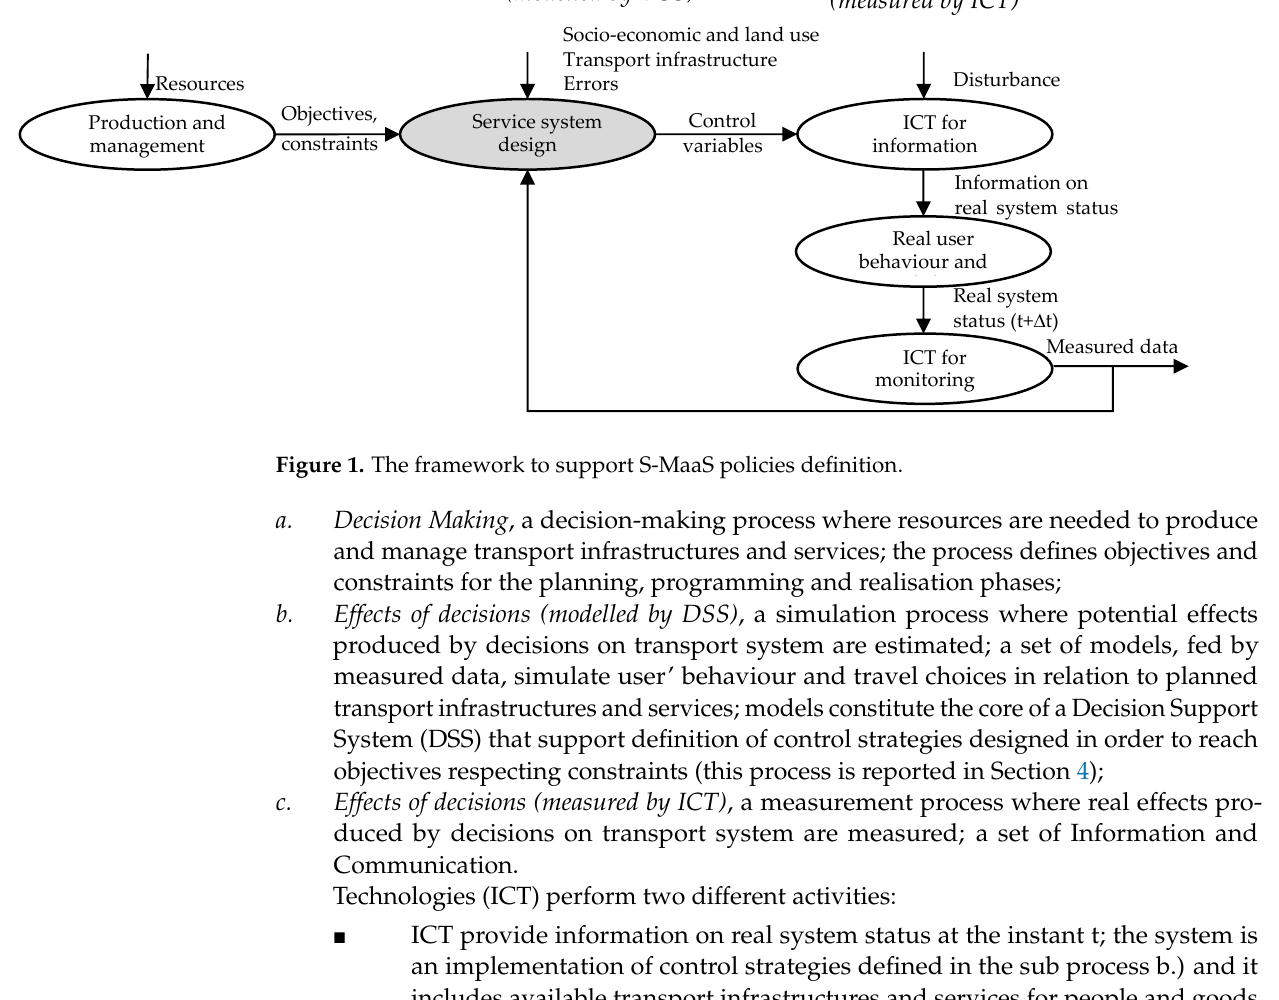
Figure 2. Transport System Models for services design (controller).